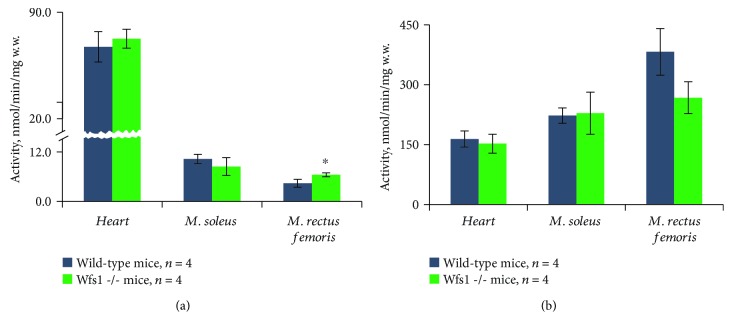
Citrate synthase (a) and pyruvate kinase (b) activity. Compared to wild type: ∗
P < 0.05.